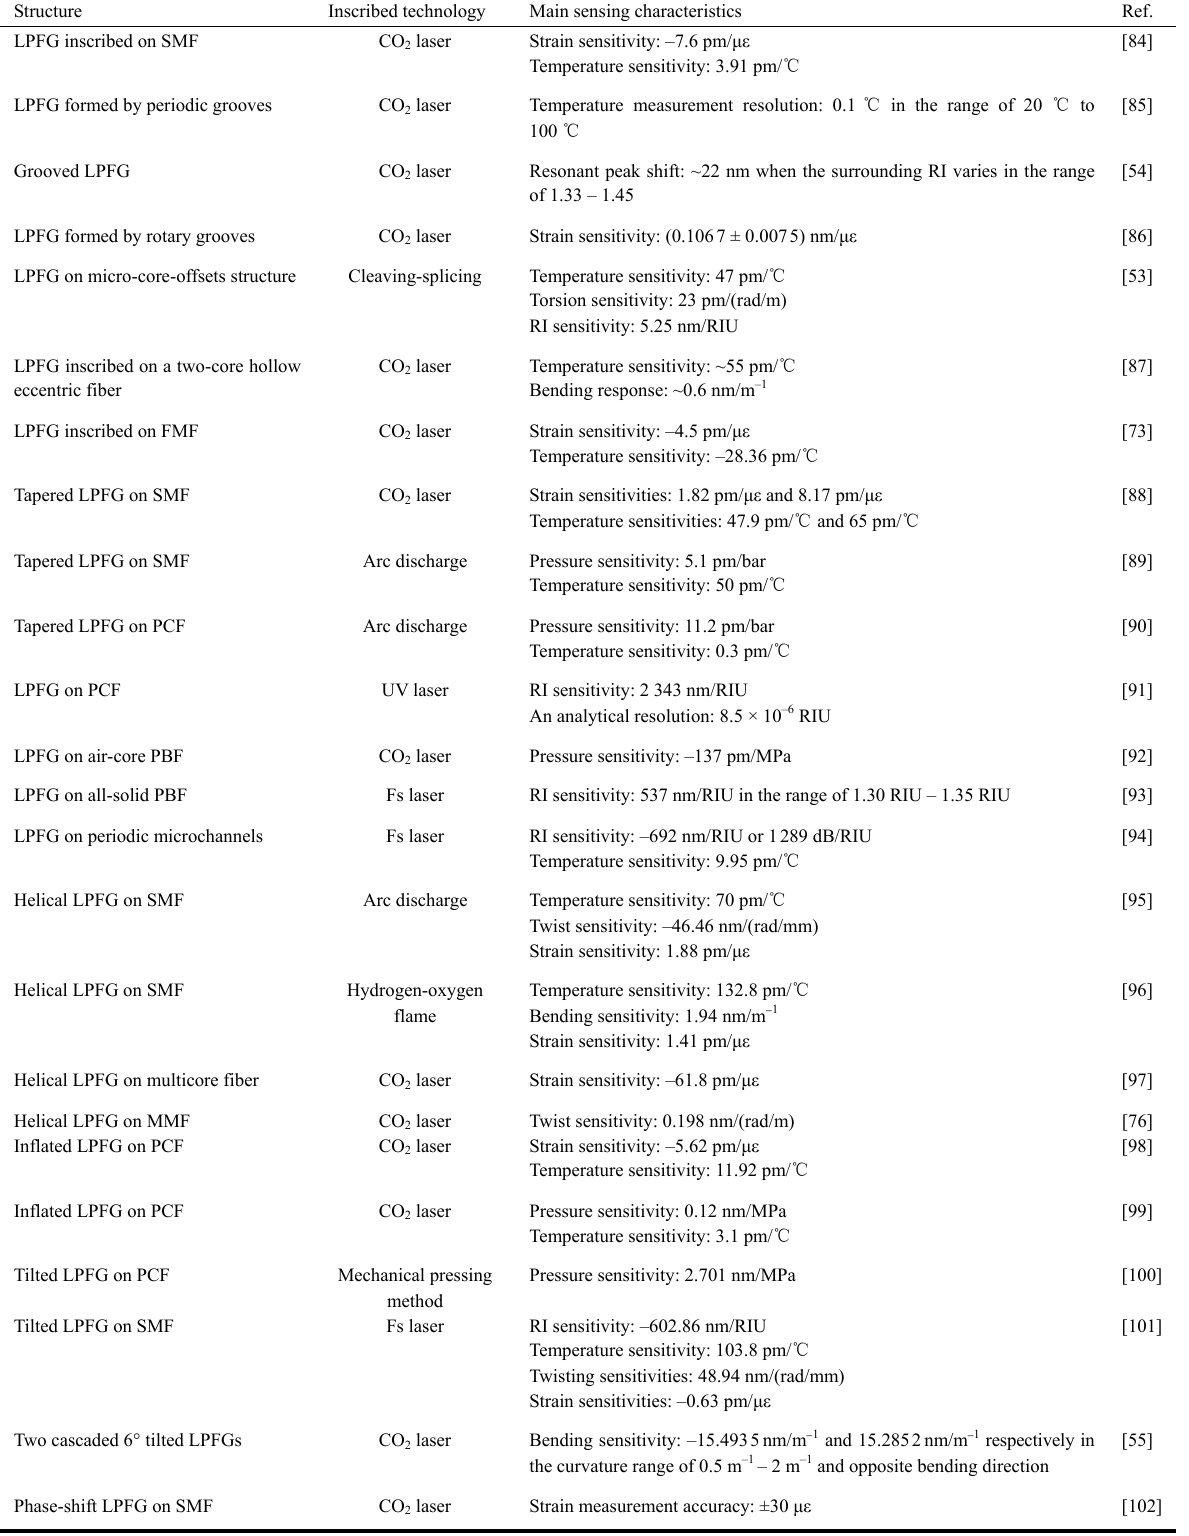
Table 4 Sensing characteristics comparison of different LPFG-based FOM sensors.